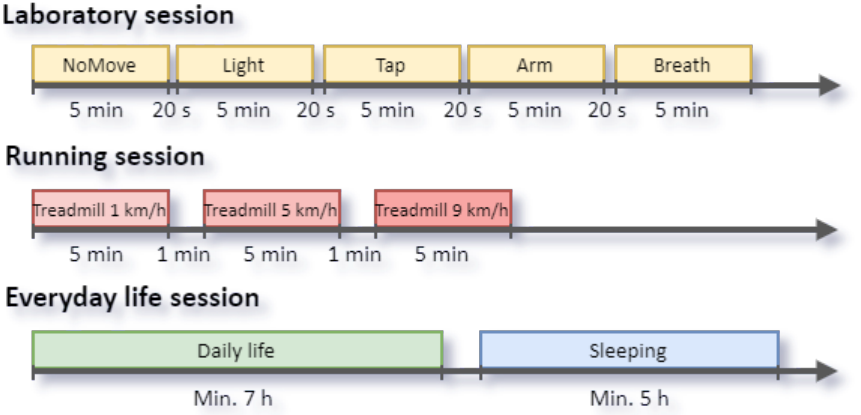
Figure 1. Experimental protocols for data collection. Only laboratory sessions were deeply analyzed in this